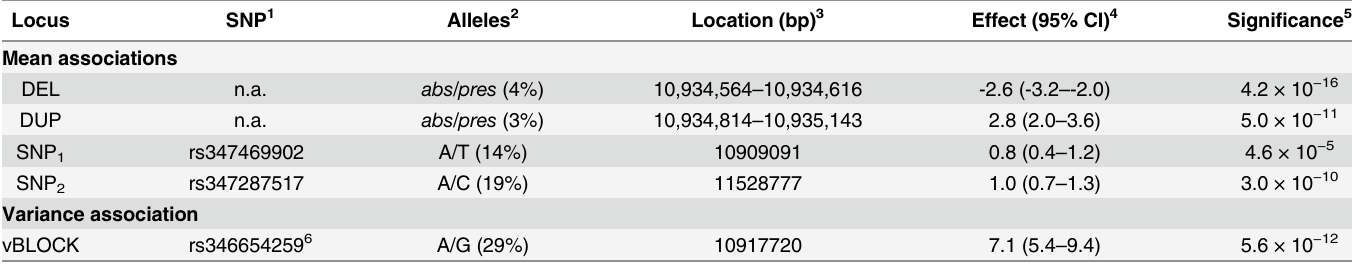
1 Name of the most signi fi cant associated SNP markers at each locus in the GWA (Mean associations) or vGWA (Variance association) analyses 2 Major allele/Minor allele (minor allele frequency). For the structural variants, abs and pres denotes absence and presence of the variant respectively 3 Location in the TAIR10 assembly 4 Estimates of mean effects ( μ g Mo /g dry weight) and 95% Con fi dence Intervals (CI) for the minor alleles from a four-locus fi xed-effect regression model including DEL, DUP, SNP 1 and SNP 2 , and the variance effect (fold increase in variance for the minor allele) for vBLOCK from a DGLM model 5 Signi fi cances for the effects estimated in 4 6 Top SNP identi fi ed in DGLM scan of